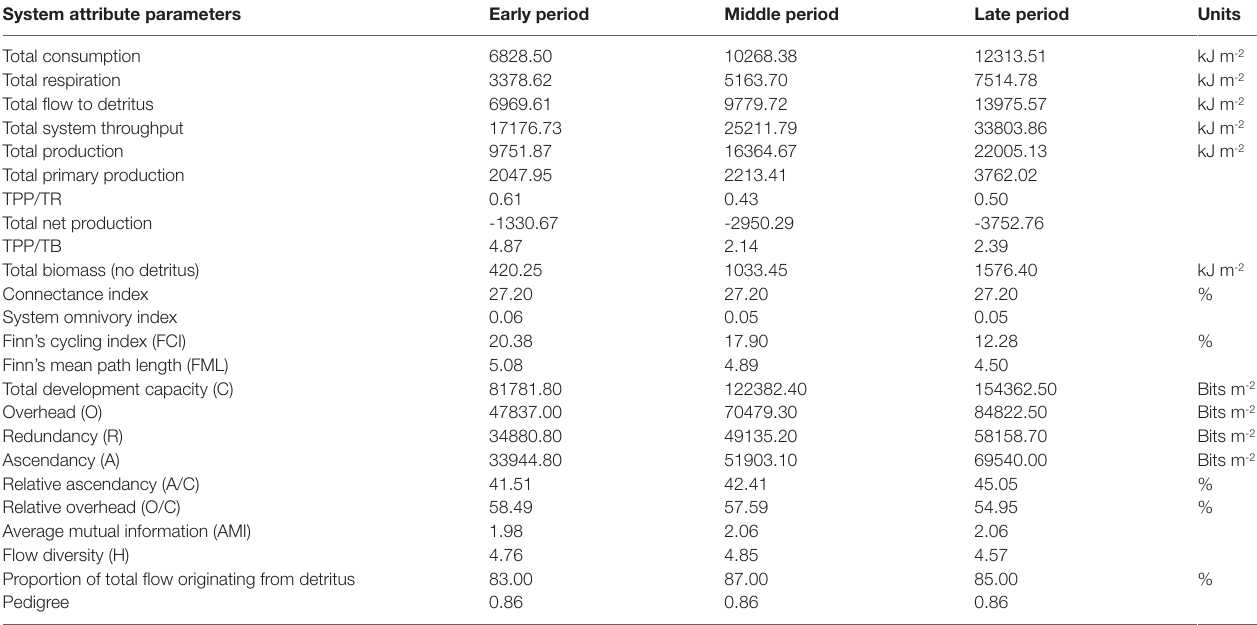
TABLE 9 | System attributes for a Portunus trituberculatus polyculture ecosystem during the early, middle, and late period, respectively. System attribute